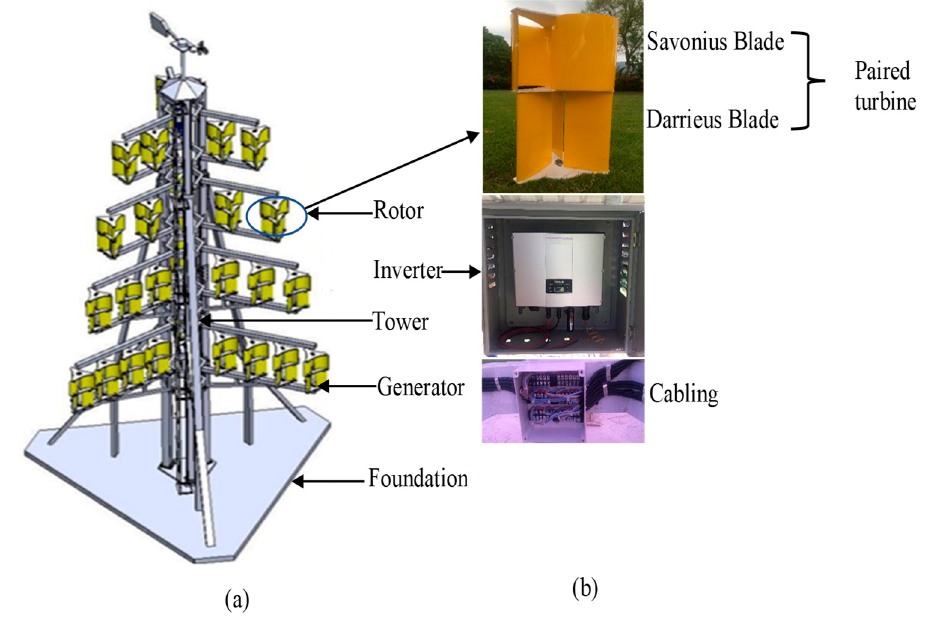
Figure 3. Wind turbine tree ( a ) and turbine structure ( b ).